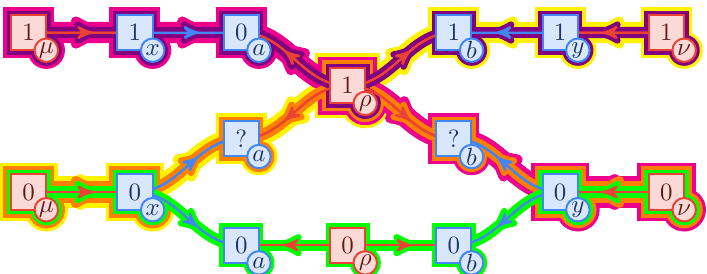
Figure 10: An incomplete possible worlds diagram for the Bell structure G 9 (Figure 9) initialized by the observed events obs xaby (0 µ 0 ρ 0 ν ) = 0 x 0 a 0 b 0 y and obs xaby (1 µ 1 ρ 1 ν ) = 1 x 0 a 1 b 1 y . The worlds are colored: wor (0 µ 0 ρ 0 ν ) green, wor (1 µ 1 ρ 1 ν ) violet, wor (1 µ 1 ρ 0 ν ) magenta, wor (0 µ 1 ρ 1 ν ) yellow, and wor (0 µ 1 ρ 0 ν ) orange.